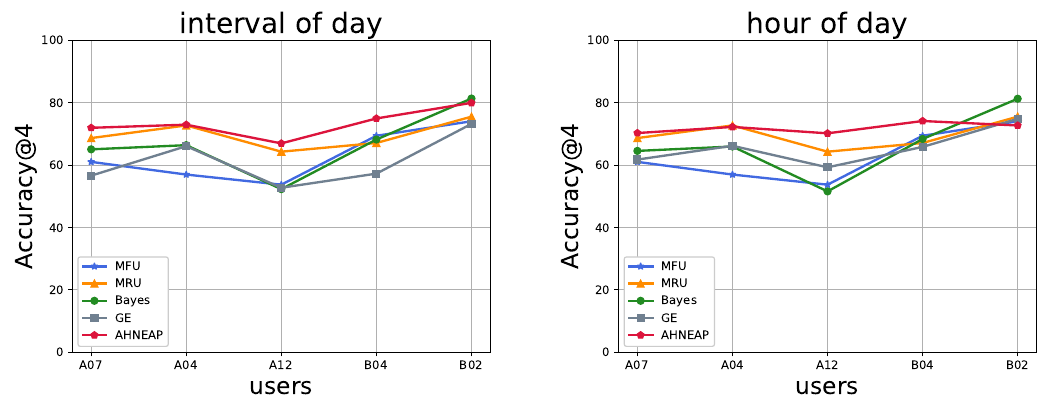
Figure 7. The comparison of prediction Accuracy @4 for the five models: MFU, MRU, traditional Bayes (Bayes), Graph Embedding (GE), and our network embedding based framework(AHNEAP) for the five users, respectively, at interval of day and hour of day temporal